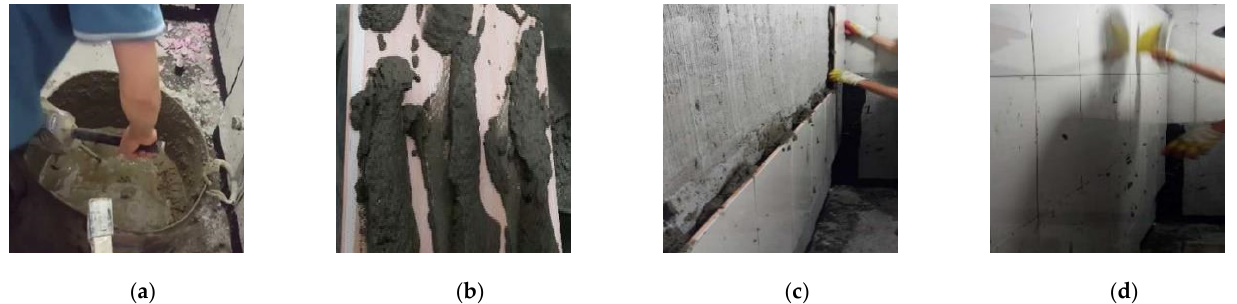
Figure 2. Common spot-bonding method procedure: ( a ) mortar preparation for spot-bonding; ( b ) mortar setting (wall) for spot-bonding; ( c ) tile installation; ( d ) notched line and surface treatment.